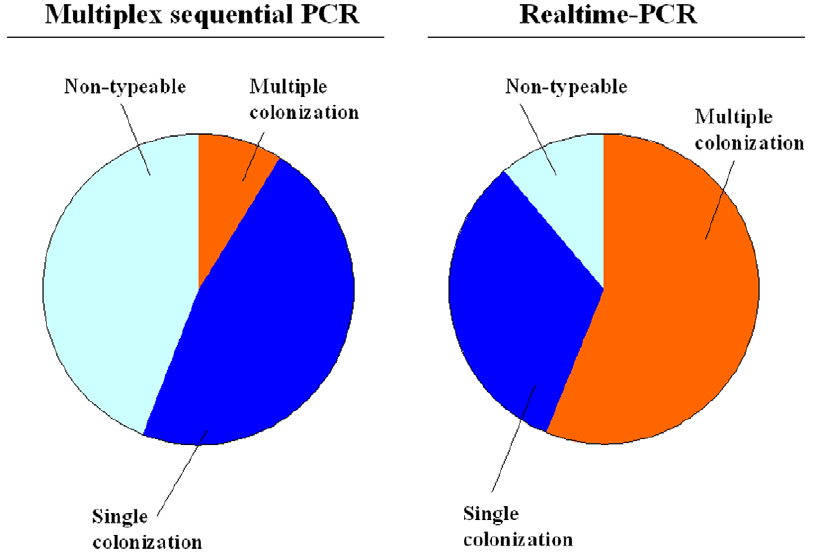
Figure 2. Presence of single or multiple pneumococcal serogroups/serotypes in nasopharyngeal swabs as evidenced by Multiplex Sequential PCR or Realtime-PCR (frequency of multiple serotypes/serogroup evaluated with Realtime PCR vs Multiple Sequential PCR p=0.003; 95%CL=1.87–39.97).